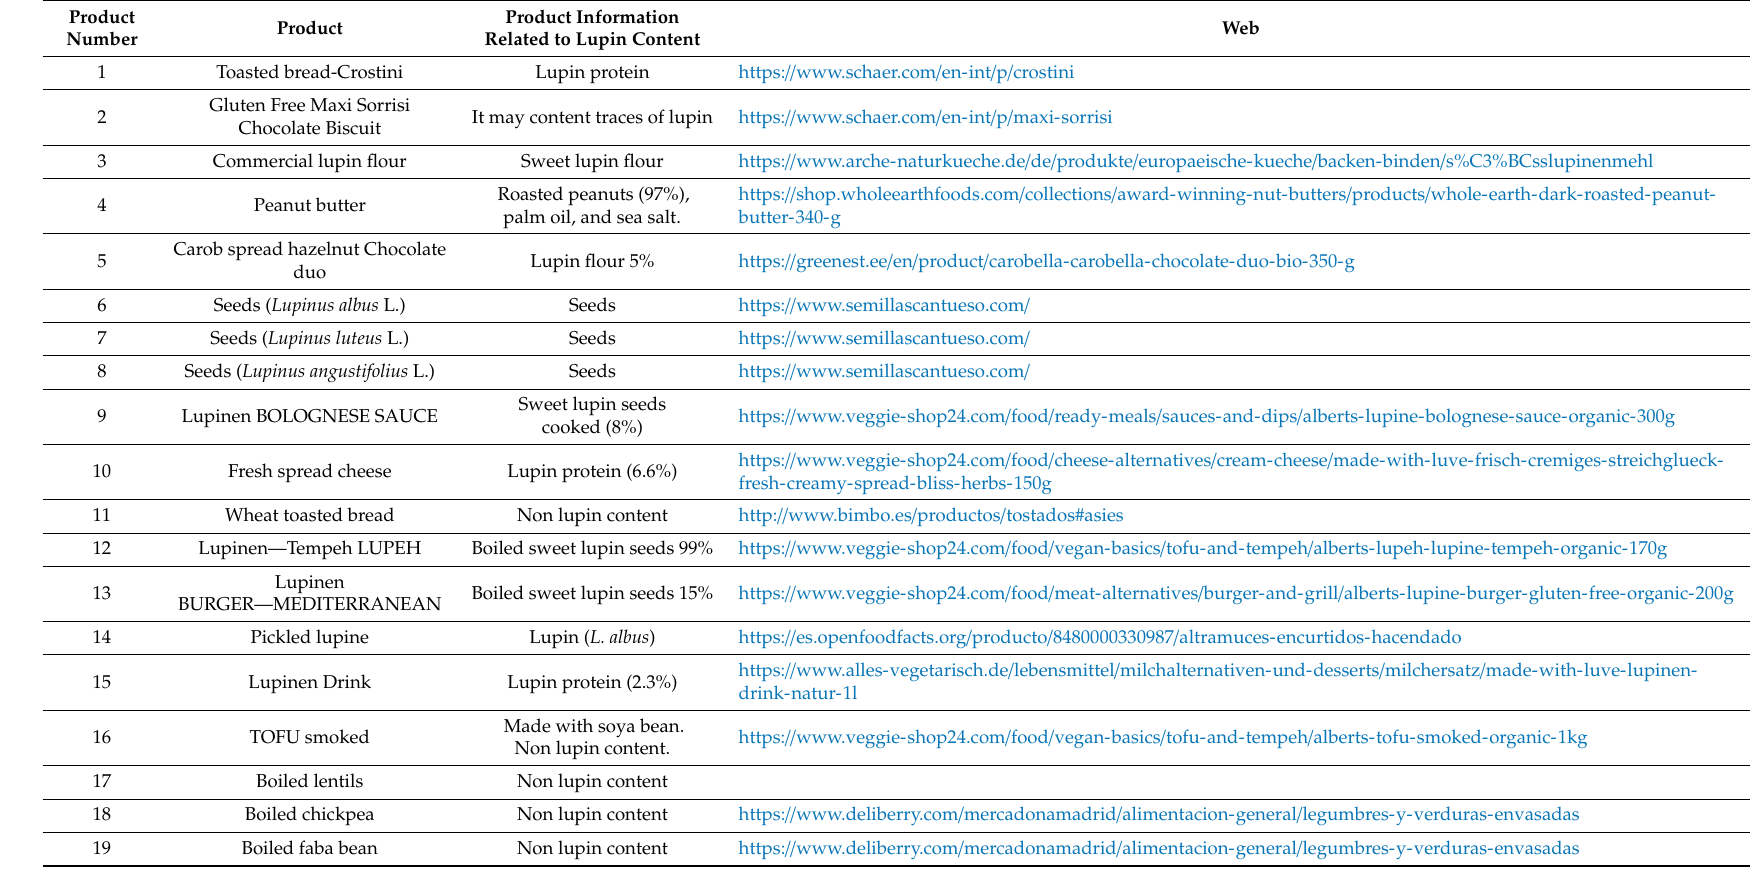
Table 1. Summary of samples analyzed in this study. The information includes brand, the lupin content, and the food processing